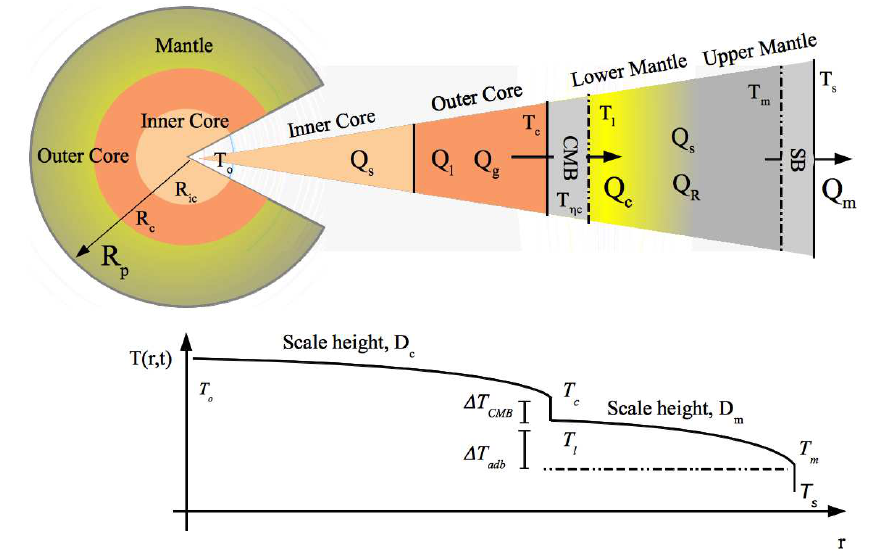
Figure 9. Schematic representation of the planetary interior. The temperature profile depicted below the slice does not use real data. Dis- tances and sizes are not to scale. (Figure from ZU13, with permission of the